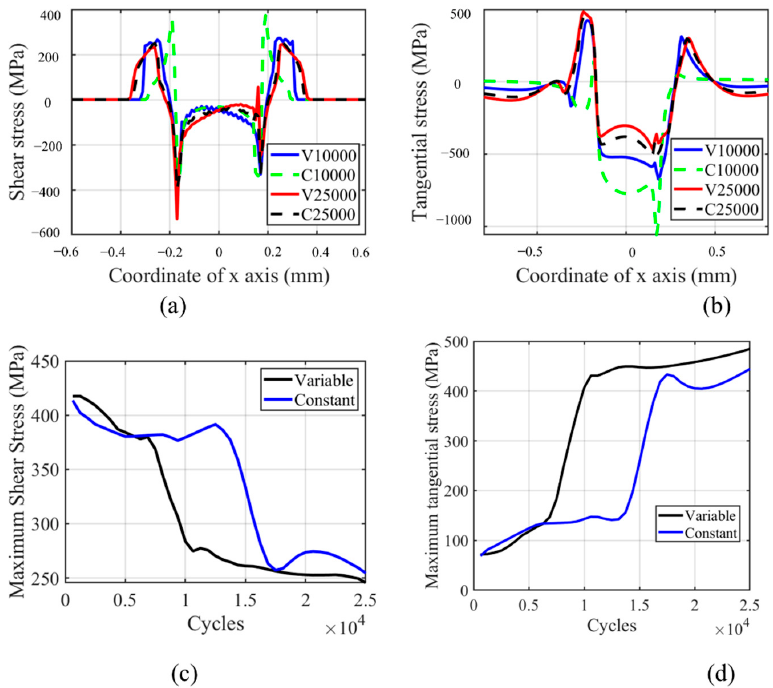
Figure 27. Profile and history of shear and tangential stress for a cylindrical pad in the partial slip regime for both CWCM and VWCM: ( a , b ) are shear and tangential stress profiles in 10,000th cycle and 250,000th cycle when δ = 10 mm, and ( c , d ) is the history of maximum shear and tangential stress, respectively